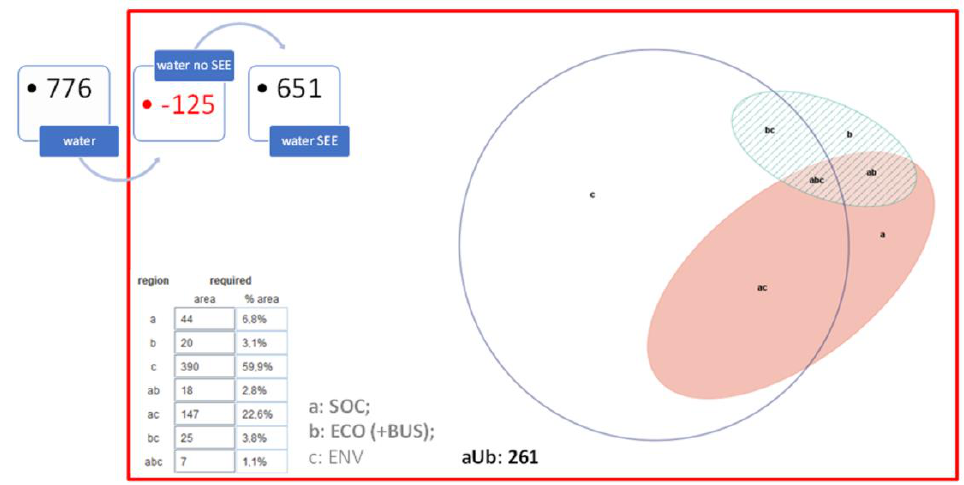
Figure 3. Dimensions in the research universe highlighting the “water SE” sample. Elaborated using eulerAPE − https://www.eulerdiagrams.org/eulerAPE (accessed on 6 January 2022).